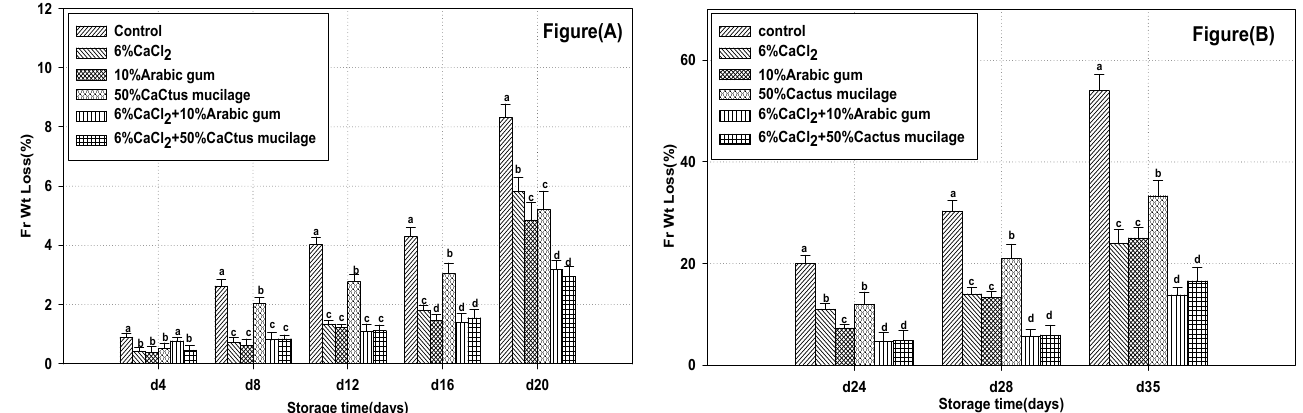
Fig. 1 (A, B ) : Effect of natural substance postharvest combination treatments with CaCl 2 on the fruit weight loss of tomato fruits at cold storage. Means fol- lowed by the same letter are not significantly different (Duncan’s multiple range test, P >